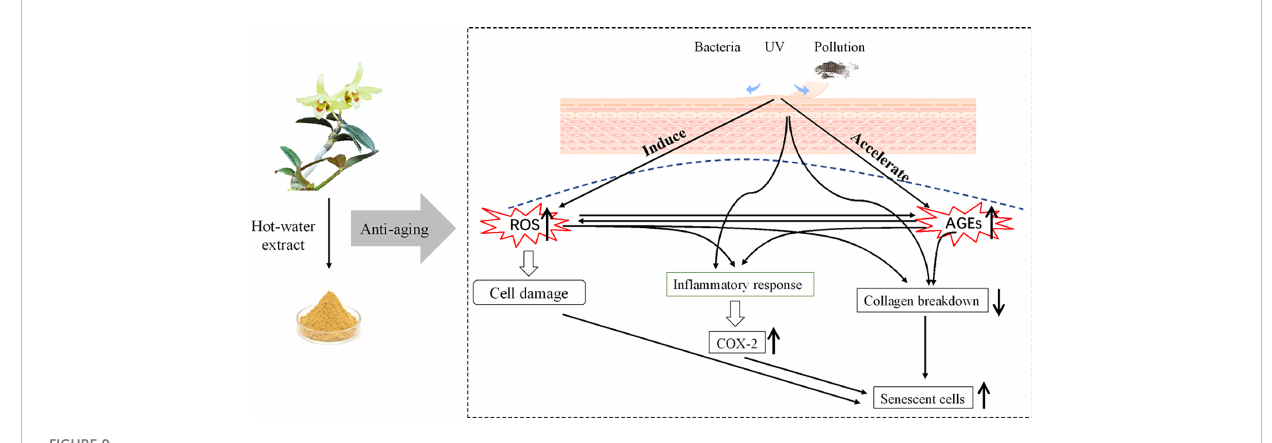
FIGURE 9 Graphic review of the anti-aging effect of D. of fi cinale fl ower aqueous extract.